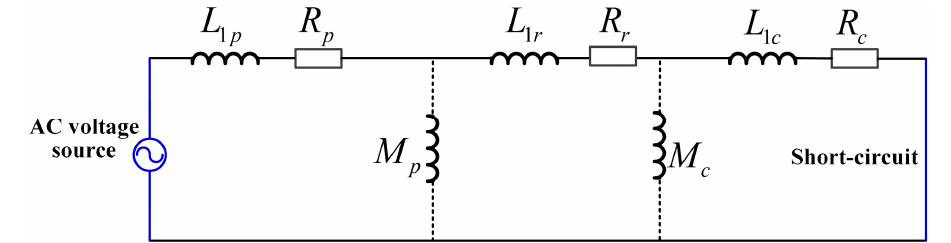
Figure 4. Measure circuit diagram of a single-equivalent phase of the brushless doubly-fed induction